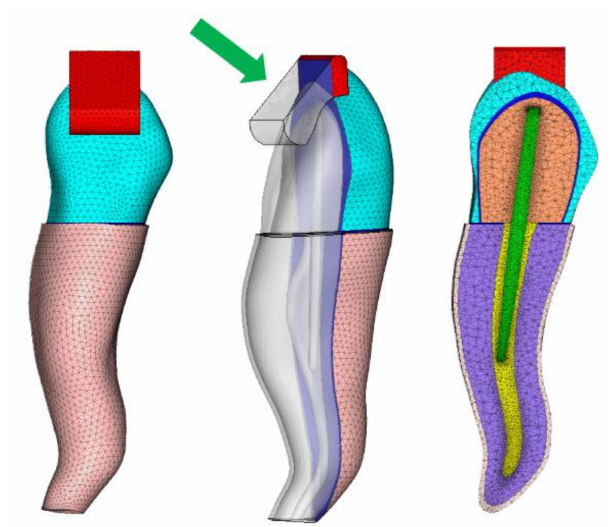
Figure 2. Models B1 and B2: Theoretical model according to the different components, mechanical properties, and technical and geometric